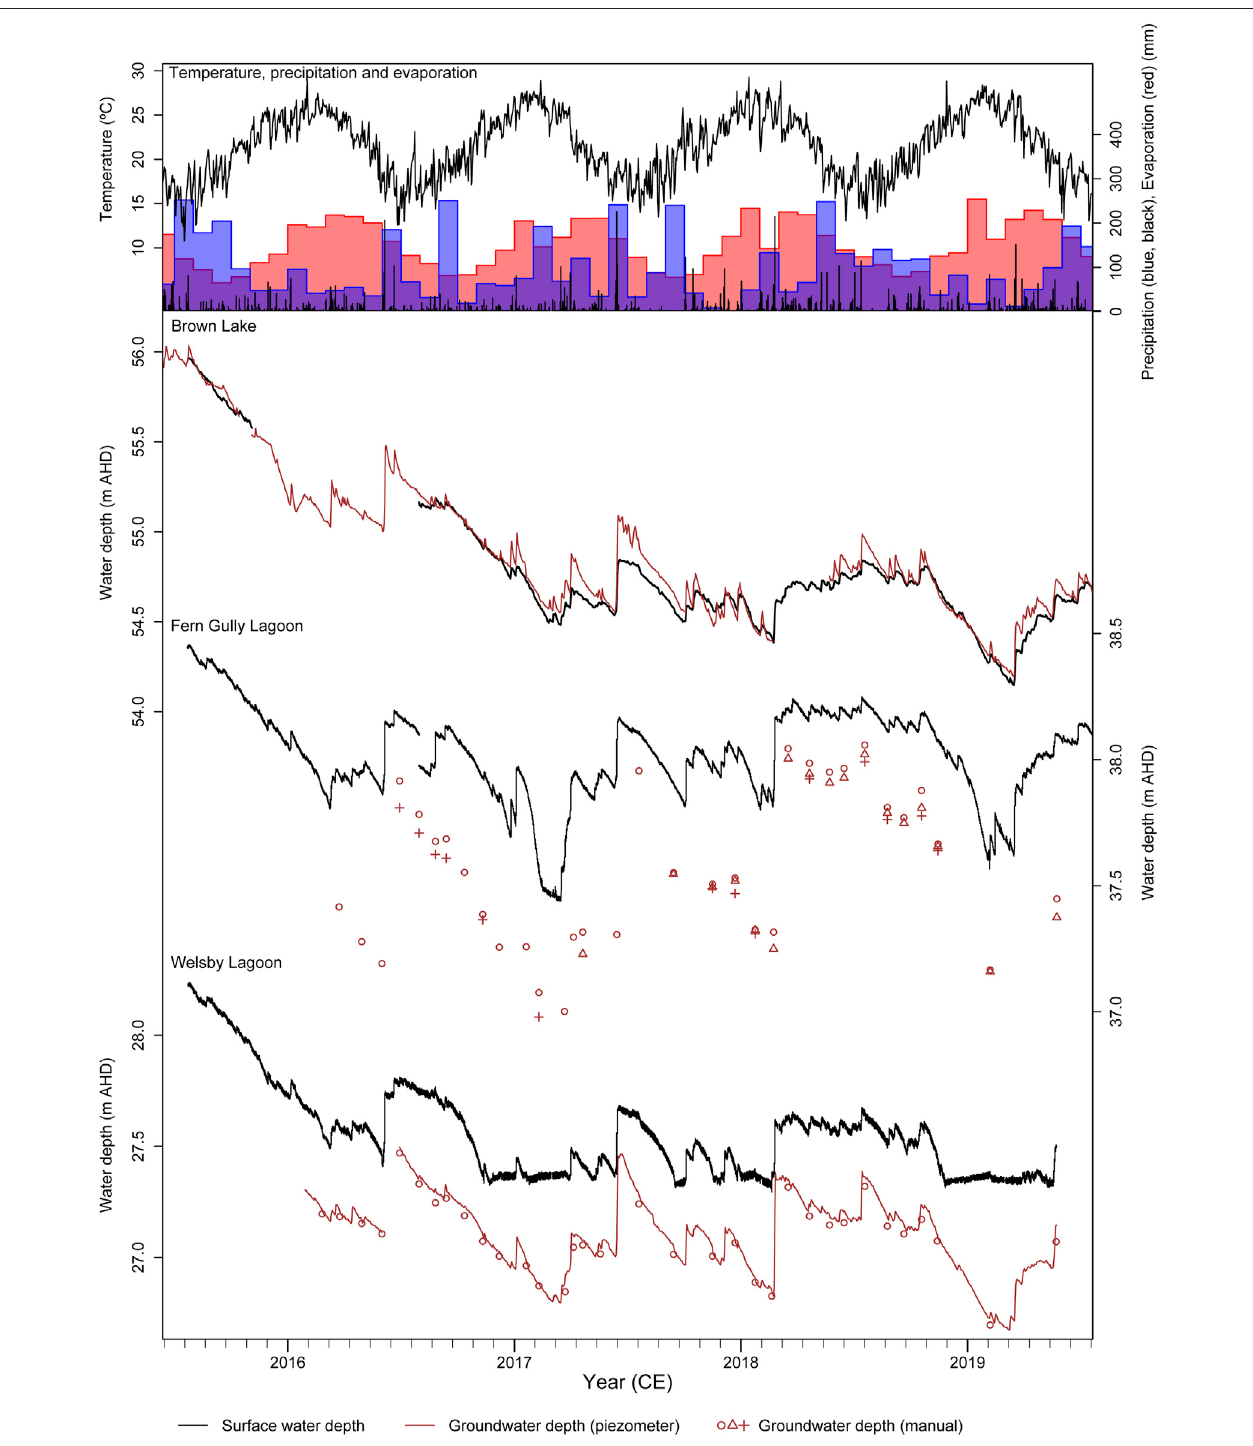
FIGURE3 | Comparison between surface and ground water levels at Brown Lake, Fern Gully Lagoon and WelsbyLagoon. In upper panel, continuousblack lineis dailymeanairtemperature,blackverticalbarsaredailytotalprecipitation(multipliedby2toassistvisibility),blueshadedareaindicatesmonthlytotalprecipitationandred shaded area indicates monthly total evaporation. Climate data represent the average of the four nearest grid points in the SILO database. In lower panels, black lines indicate continuously monitored surface water levels, red lines indicate continuously monitored groundwater levels and red symbols indicate manually determined groundwater levels at up to three different locations (indicated by different symbols) at each site.